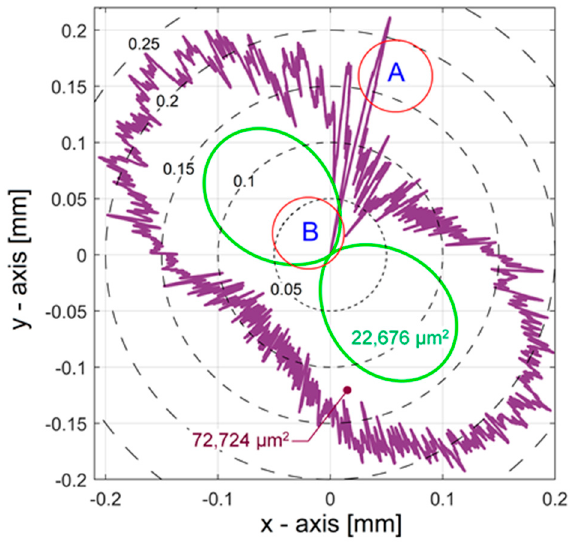
Figure 16. The evolution of TFR 2 generated by x e and y e and TFR 2 generated only by x a and y a (with green color).